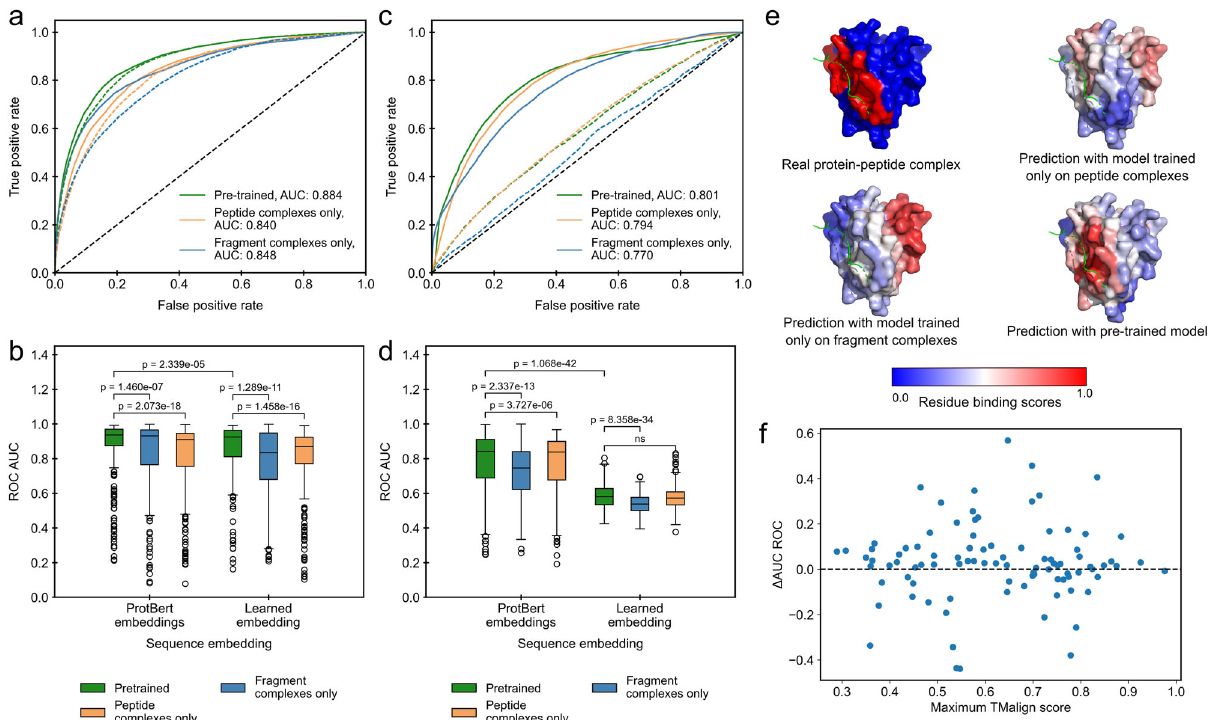
Fig. 2 Impact of transfer learning on model performance on the peptide complex validation dataset. a ROC curves on all residues in the dataset using predictions from PepNN-Struct trained on different datasets with different sequence embeddings. Solid lines indicate models that use ProtBert embeddings. b Comparison of the distribution of ROC AUCs on different input proteins using predictions from PepNN-Struct trained on different datasets with different sequence embeddings (Wilcoxon signed-rank test, n = 311 protein-peptide complex structures). c ROC curves on all residues in the dataset using predictions from PepNN-Seq trained on different datasets with different sequence embeddings. Solid lines indicate models that use ProtBert embeddings. d Comparison of the distribution of ROC AUCs on different input proteins using predictions from PepNN-Seq trained on different datasets (Wilcoxon signed-rank test, n = 311 protein-peptide complex structures). e Predictions of the binding site of the SPOC domain of PHF3 (PDB code 6IC9) using PepNN- Struct trained on different datasets. f Relationship between the change in AUC ROC when PepNN-Struct is pretrained and the maximum TMalign score of chains in the test dataset with chains in the pre-training dataset. Boxplot centerlines show medians, box limits show upper and lower quartiles, whiskers are 1.5 the interquartile range and points show